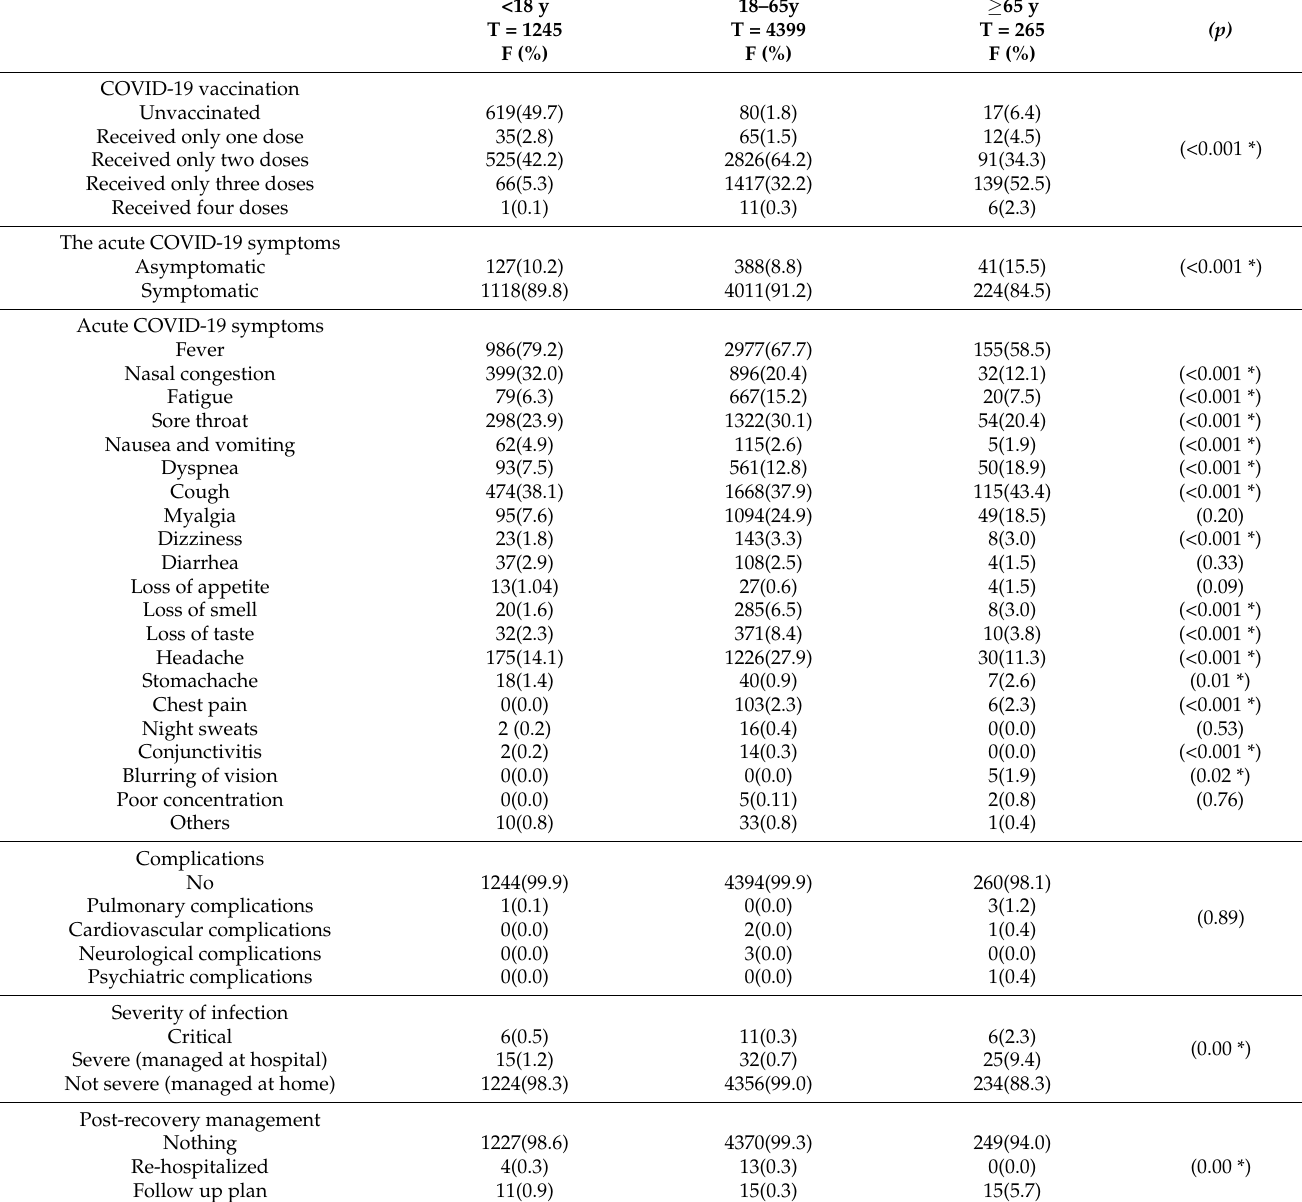
Table 2. The history of COVID-19 vaccination, and acute SARS-Cov2 infection among different age